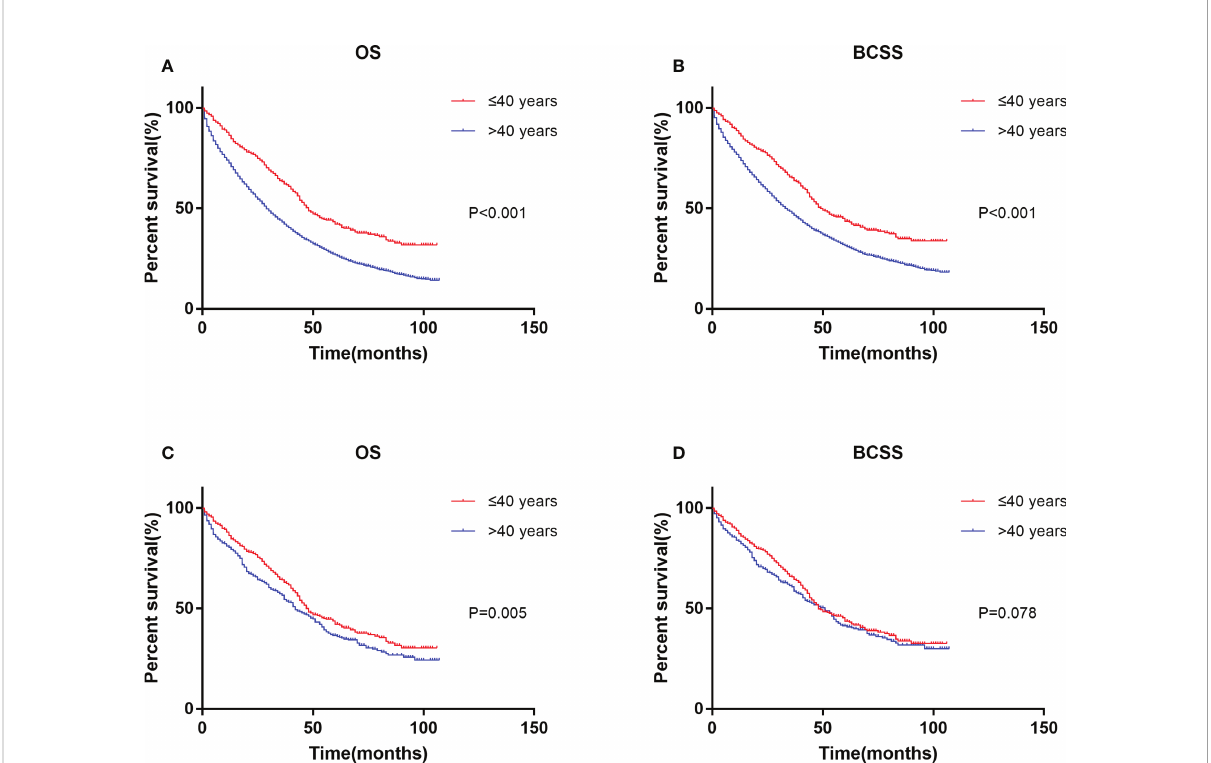
FIGURE 2 Kaplan – Meier curve of overall survival (A) and cancer-speci fi c survival (B) by age groups before PSM. Kaplan – Meier curve of overall survival (C) and cancer-speci fi c survival (D) after PSM. PSM, propensity score